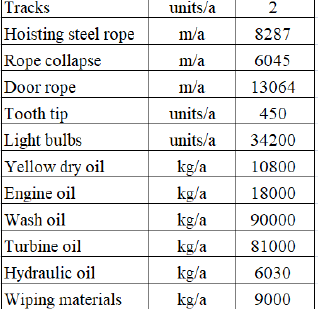
Figure 7. Material consumption report of truck-shovel equipment.